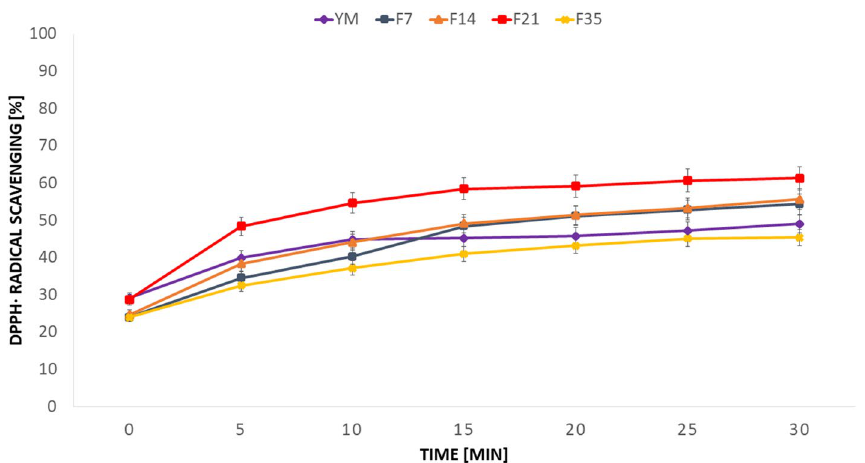
Figure 2. The changes DPPH radical scavenging capacity over time for 250 μg/mL of Yerba Mate extract and Kombucha ferments. Values are mean of three replicate determinations (n =